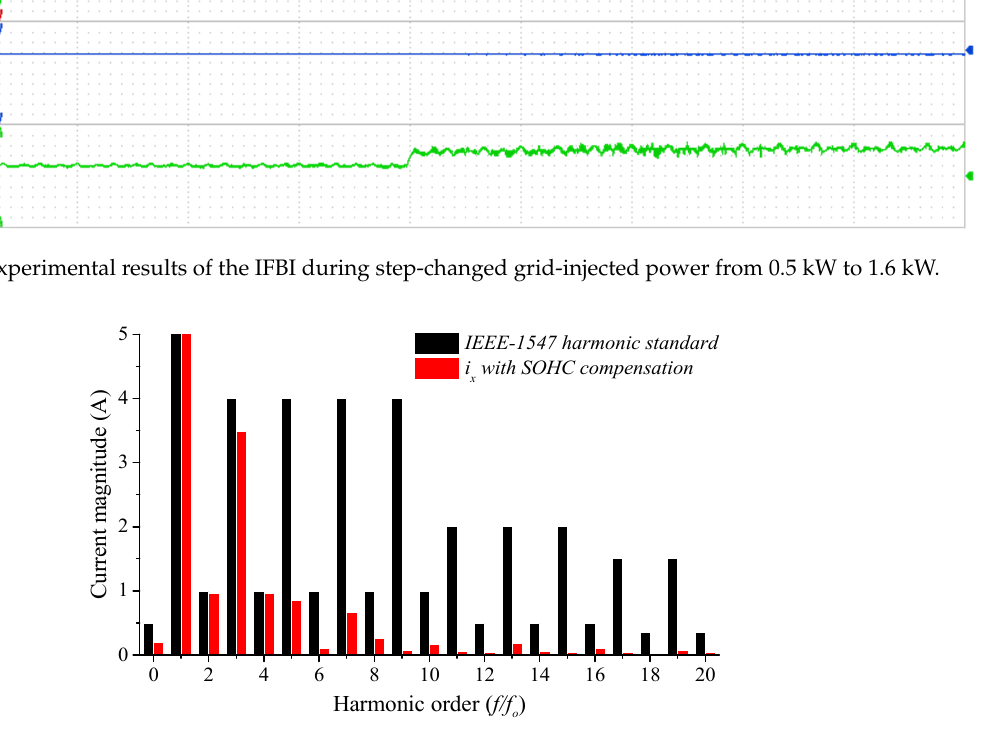
Figure 13. Grid current harmonic orders in comparison to IEEE-1547 harmonic standards.